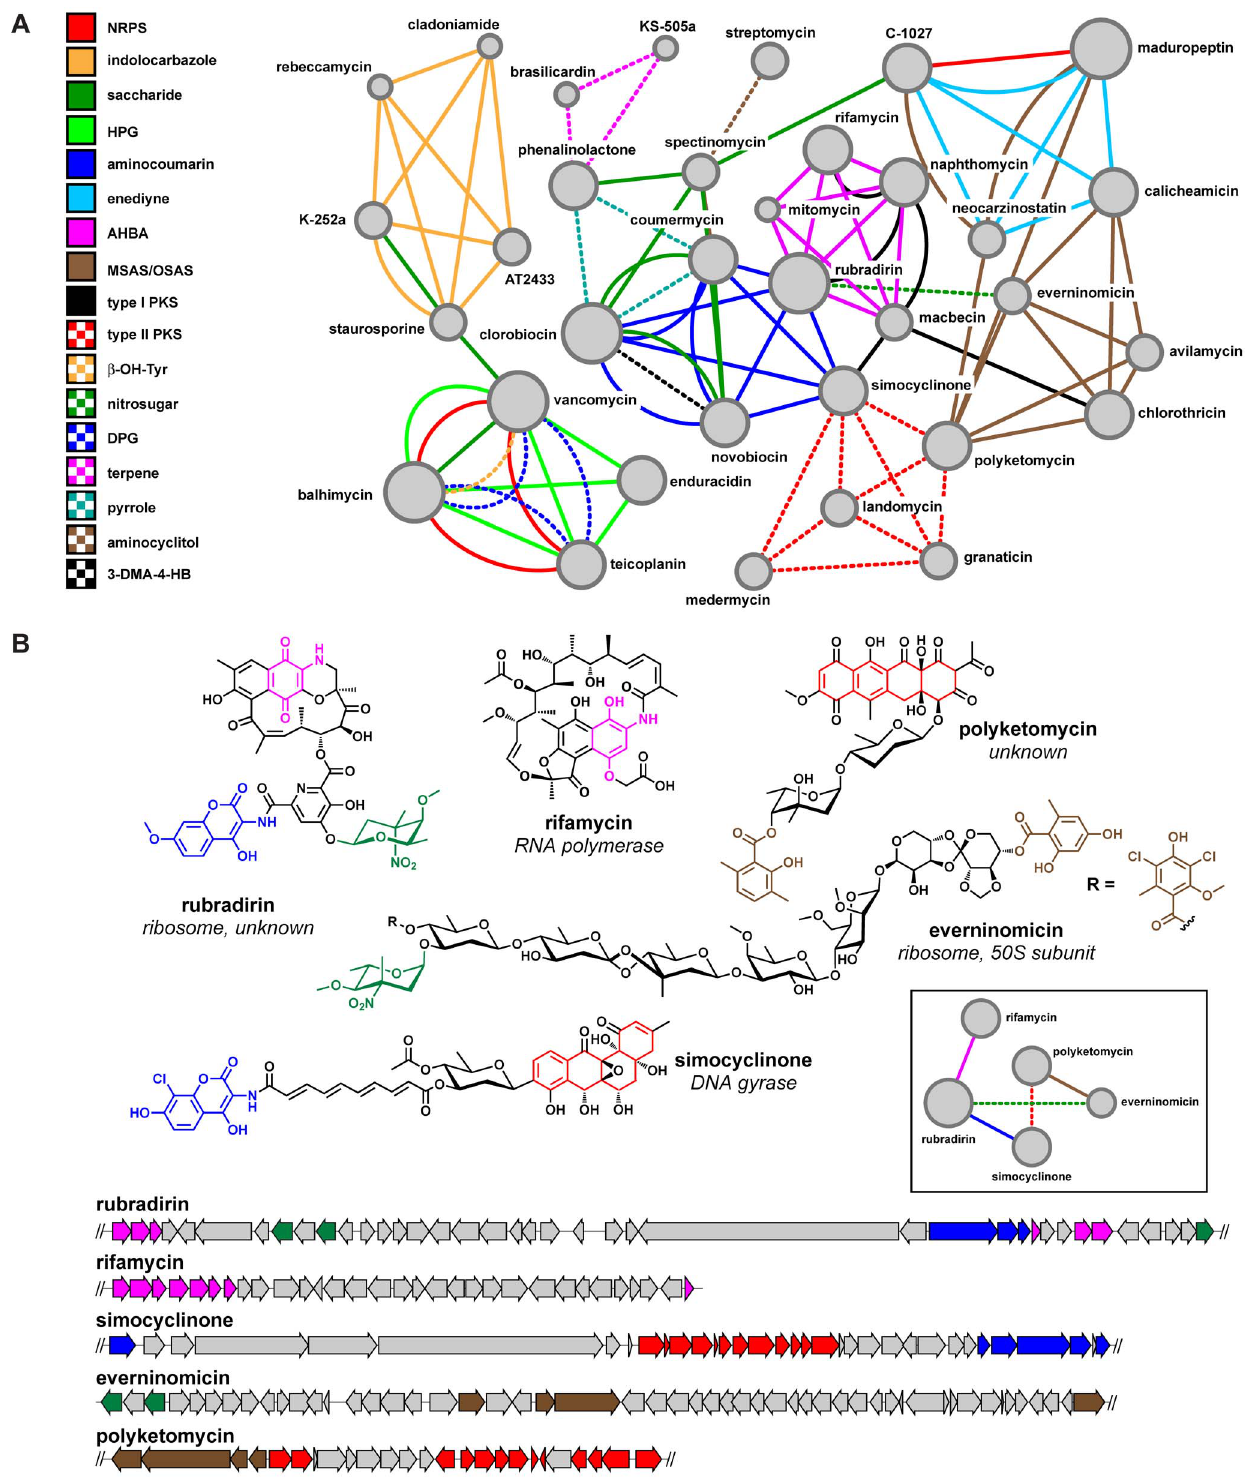
Figure 2. Complex BGC architectures evolve through new combinations of sub-clusters that are shared between multiple gene cluster types. a , Network of sub-clusters shared among 34 known BGCs. Nodes represent BGCs, and node size indicates the number of sub-clusters present in the gene cluster that are shared with other BGCs within the network. Edges represent shared sub-clusters, coded by color. The pattern of sharing indicates that many sub-clusters are regularly transferred between BGCs of different types. In the interpretation of this analysis, it should be kept in mind that in rare cases different biosynthetic routes (and hence, different sub-clusters) exist towards the same moiety. b , A sub-network from a showing the shared sub-clusters among the BGCs for rubradirin, rifamycin, simocyclinone, everninomicin, and polyketomycin, as well as the chemical moieties encoded by the sub-clusters.